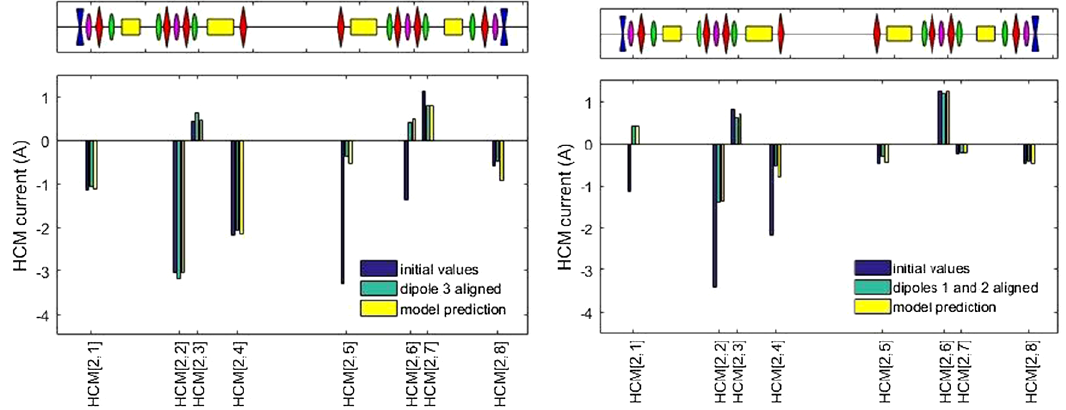
(red).FIG. 13. Corrector pattern before and after the gradient dipole